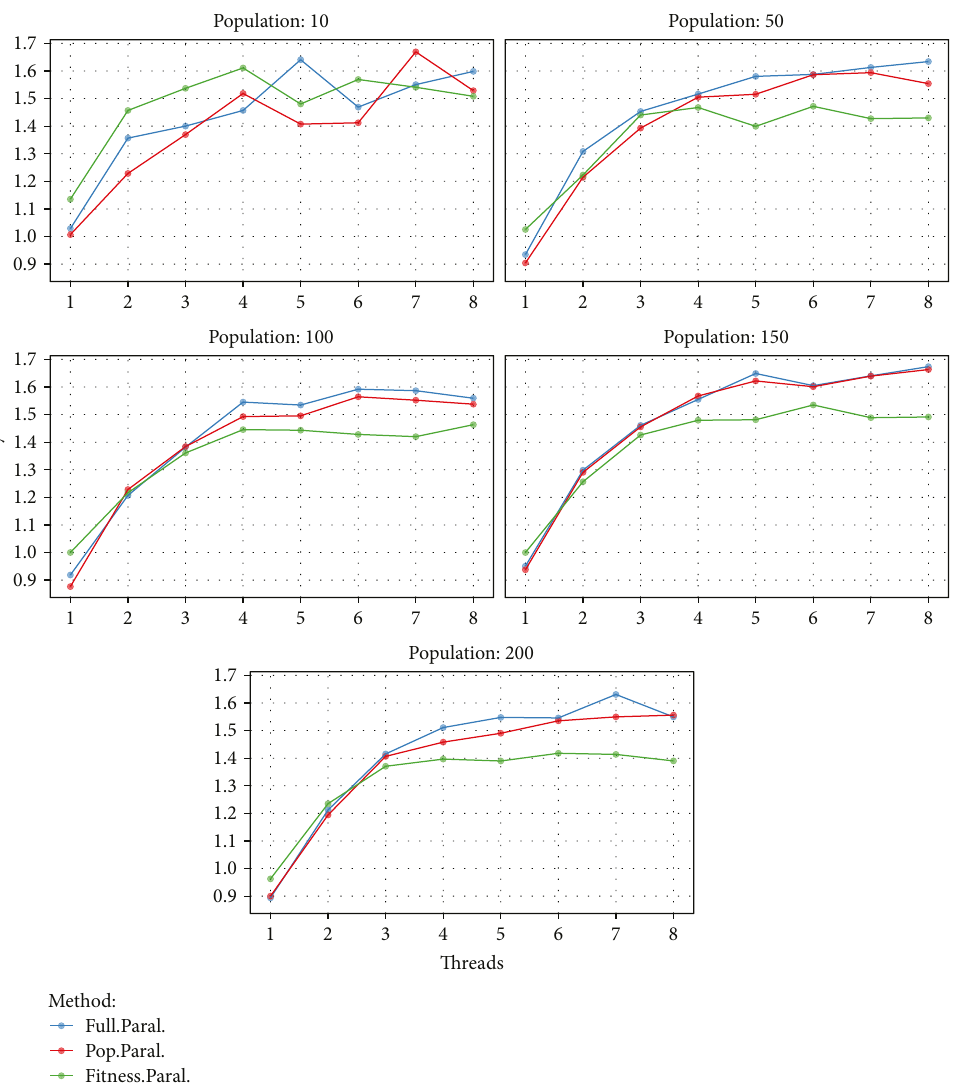
Figure 5: Speed-up plots for solutions having 10 dimensions, with population sizes of 10, 50, 100, and 150 individuals, and using from 1 to 8